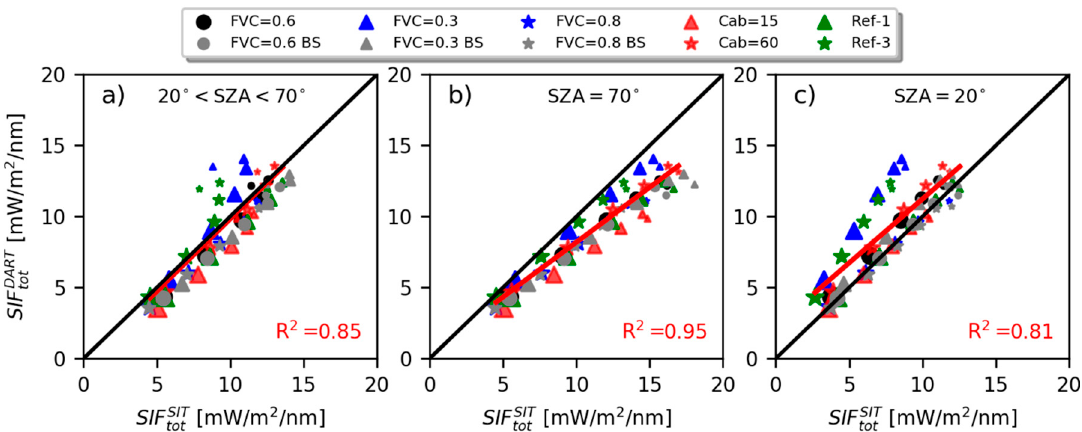
Figure 5. Comparison of the total emitted SIF ( SIF SIT ) using di ff erent SIF escape probabilities with DART reference values ( SIF DART ): ( a ) plots using f esc estimated at varying solar zenith angles from 20 ◦ to 70 ◦ ; ( b , c ) plots using f esc estimated at constant solar zenith angle (i.e., solar zenith angle (SZA) = 70 ◦ for ( b ); SZA = 20 ◦ for ( c ).